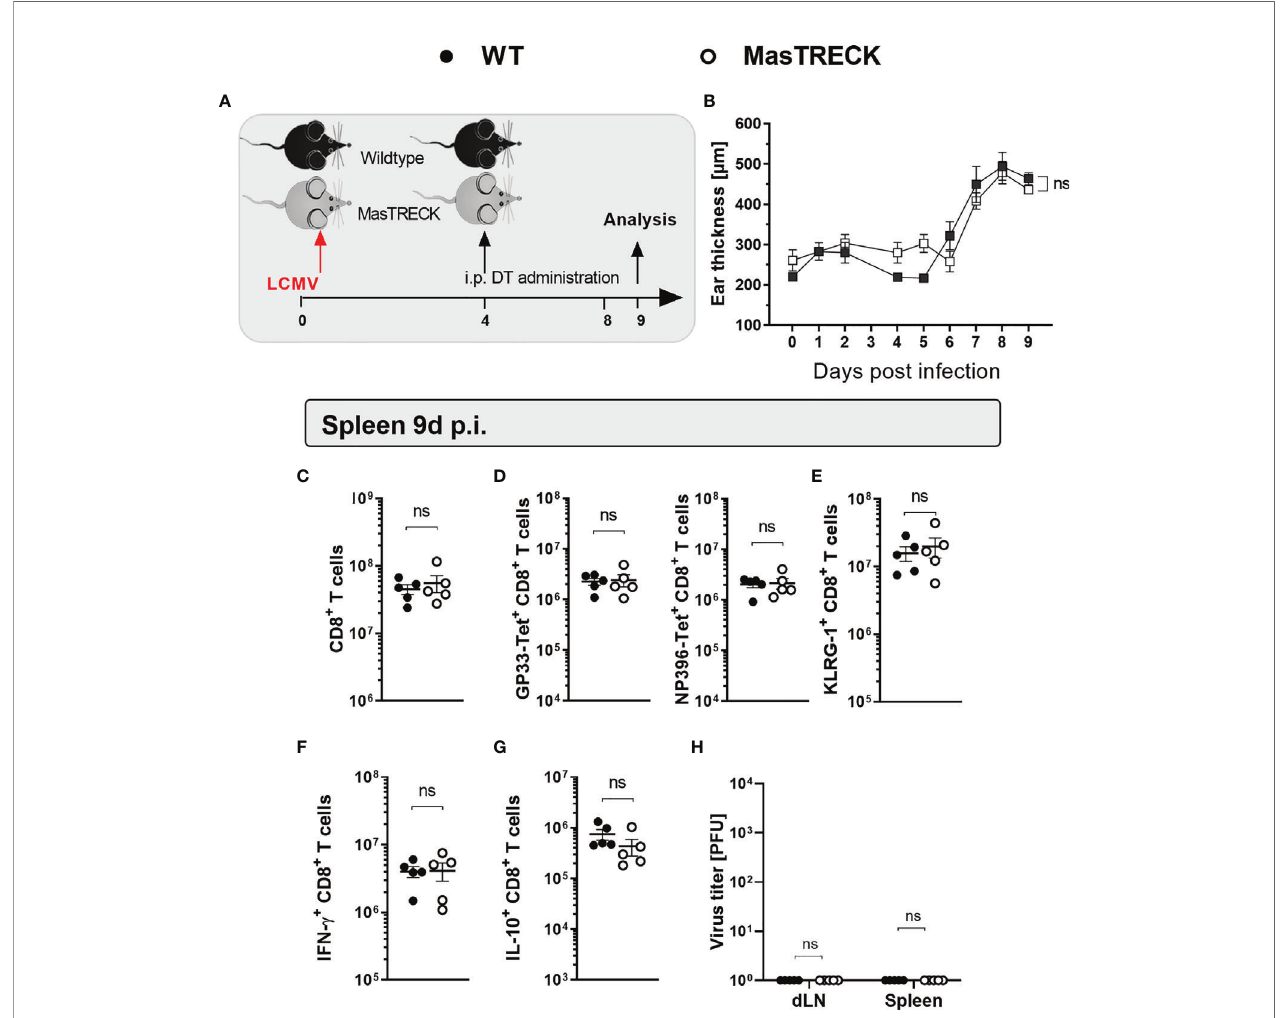
FIGURE 6 | Mast cell depletion after LCMV infection does not impair virus-speci fi c CD8+ T cell responses. (A) Schematic experimental layout to analyze virus- speci fi c CD8 + T cell responses in WT and MasTRECK mice that were fi rst infected with LCMV into the ventral side of the ear pinna and subsequently treated with 250 ng DT i.p. for 5 consecutive days between days 4-8 p.i. (B) Ear thickness daily measured using a caliper during 9 days after LCMV infection. (C) Absolute numbers of CD8 + T cells, (D) GP33-Tet + and NP396-Tet + CD8 + T cells as well as (E) KLRG1 + CD8 + T cells in the spleen of WT and MasTRECK mice at day 9 post infection. (F) Absolute numbers of IFN- g – and (G) IL-10 – producing CD8 + T cells in the spleen of WT and MasTRECK mice after ex vivo restimulation with GP33 and NP396 peptides at day 9 post infection assessed by fl ow cytometry. (H) Virus titers in ear-dLN and spleen of WT and MasTRECK mice assessed by plaque assay at day 9 post intradermal LCMV infection. All experiments were performed at least twice, and each experimental group included n ≥ 4. Data are representative and expressed as mean ± SD. Statistically signi fi cant differences are analyzed by t -test and indicated as follows: ns = not signi fi